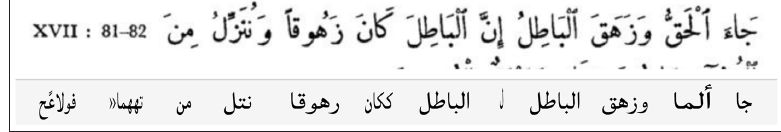
Figure 15: Highly vocalized Qur’anic passage that is transcribed poorly due to